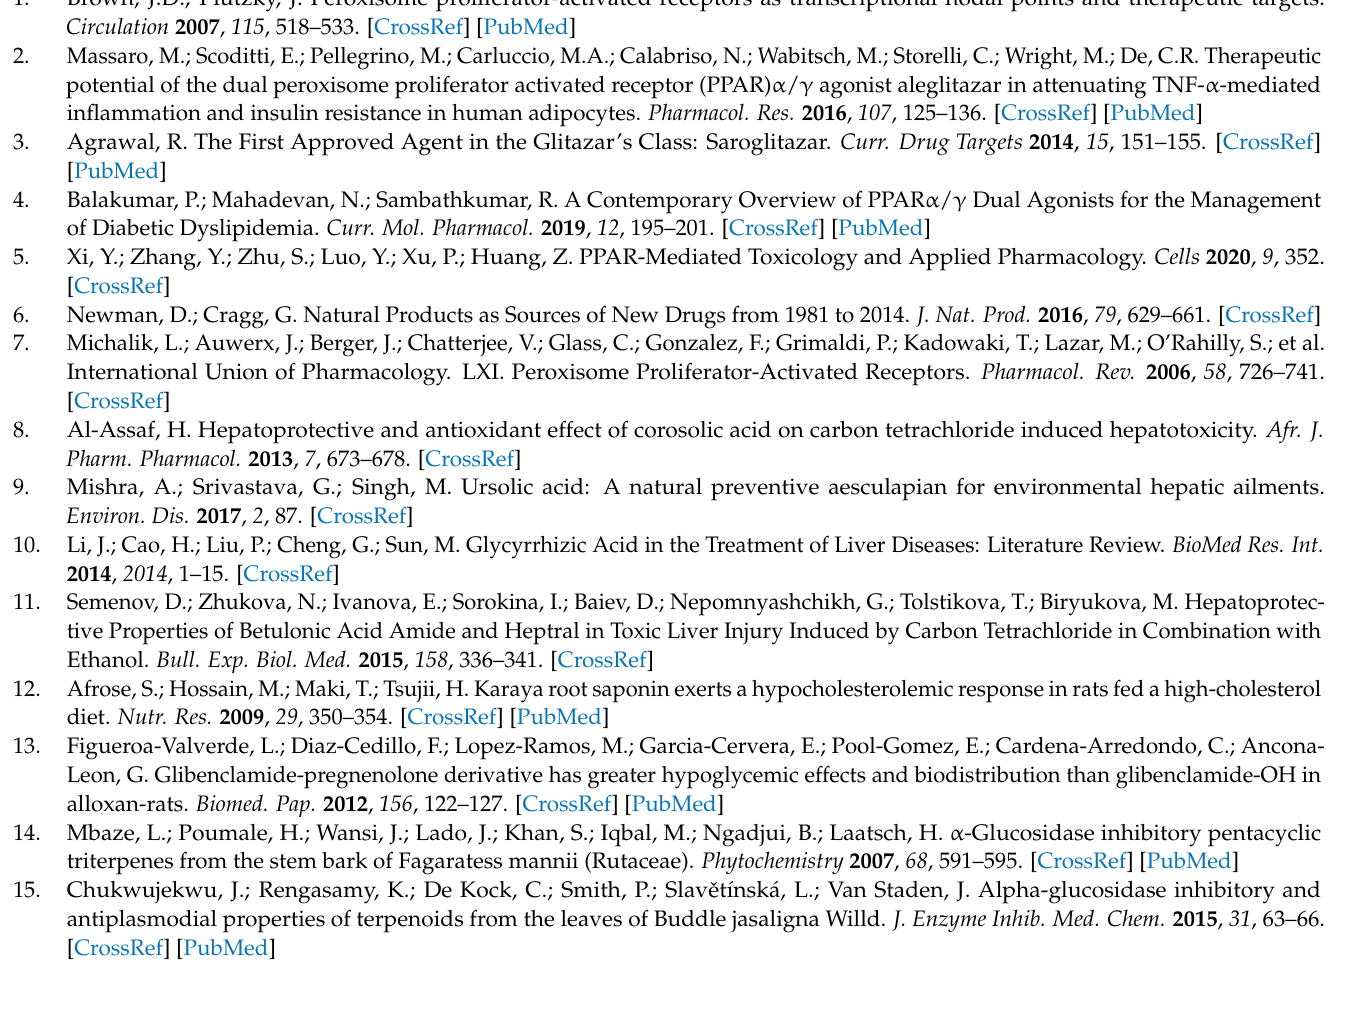
compound 16c . Figure S11. 1H NMR spectrum of compound 16e . Figure S12. 1H NMR spectrum of compound 16f . All 13C NMR can be found below 1H NMR